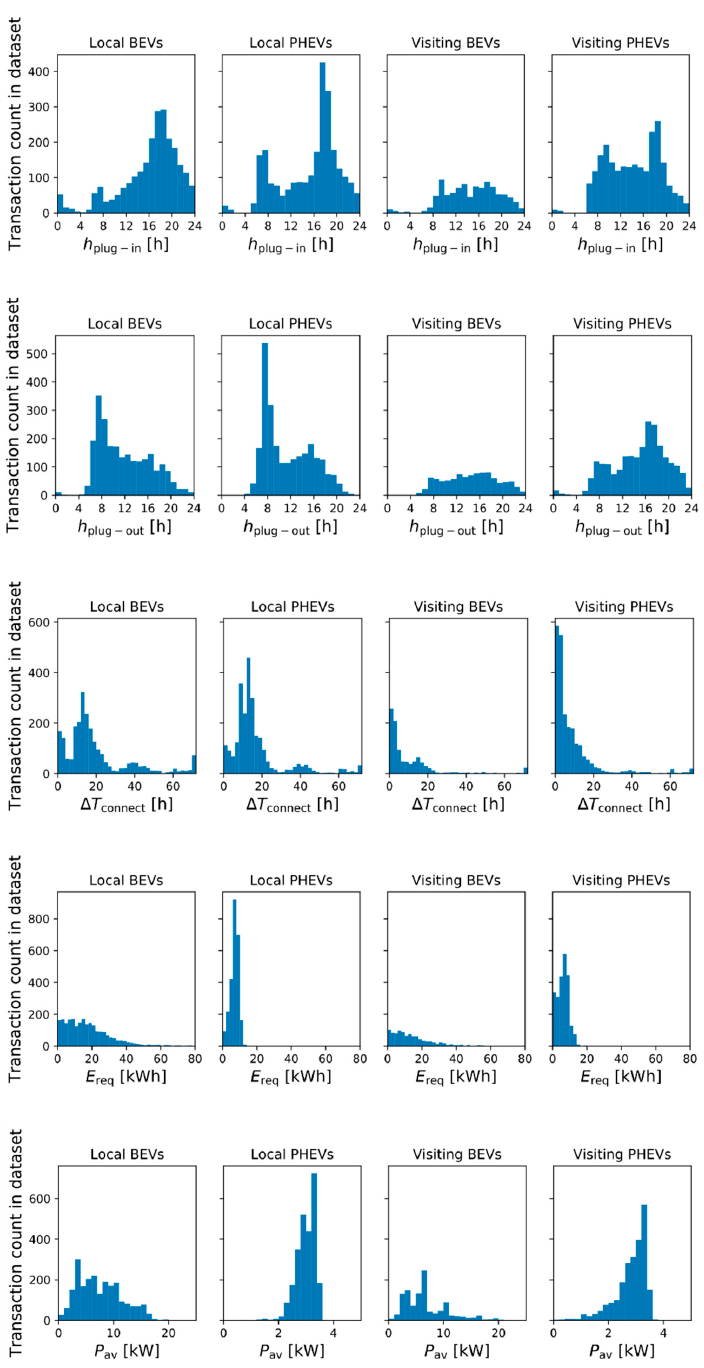
Figure 4. From top to bottom, the histograms for h plug-in , h plug-out , ∆ T connect , E req , and the average transaction power P av are given for all transactions in the measured data, per EV category.